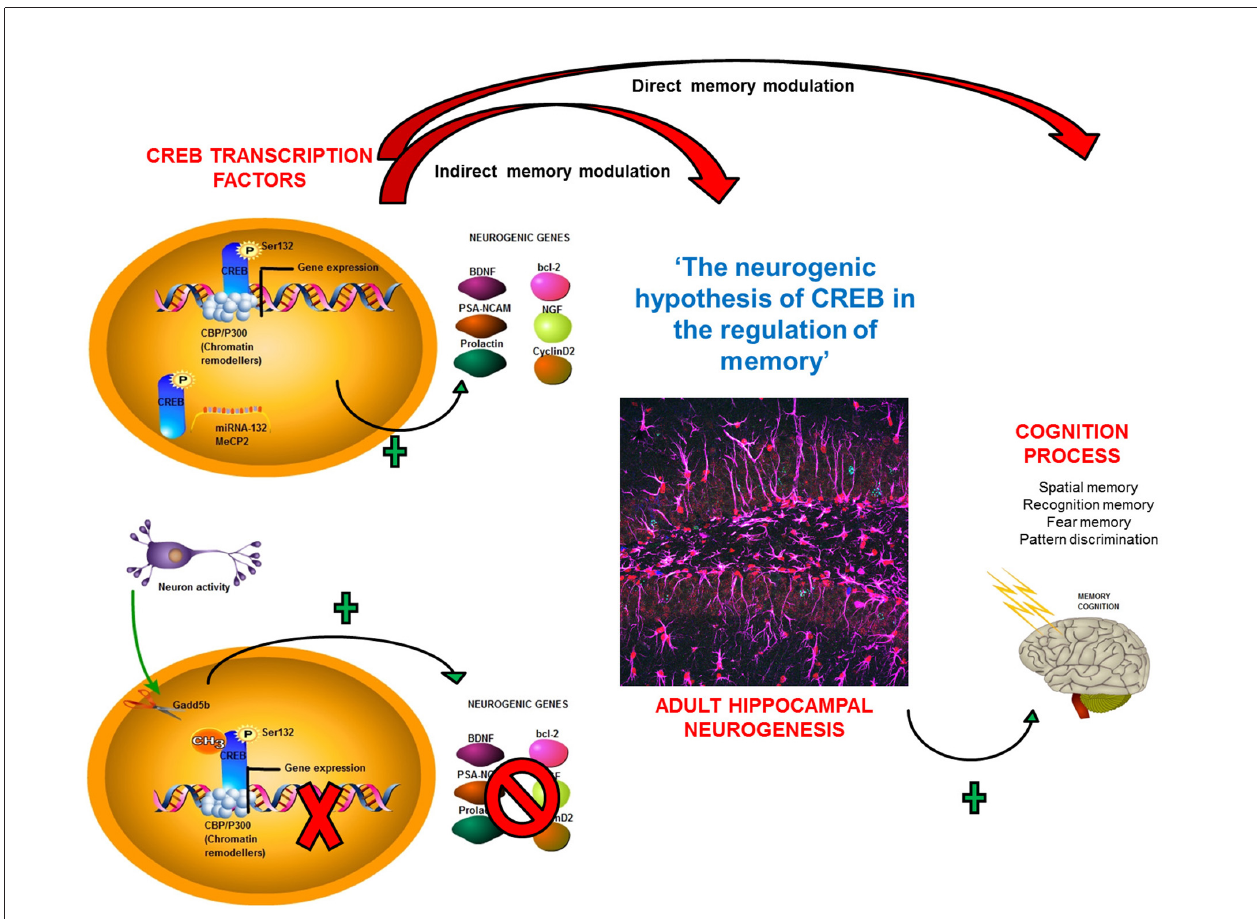
FIGURE 3 | Neurogenic hypothesis for CREB’s role in the regulation of memory. A summary of how CREB can influence this cognitive process of memory formation through its direct participation in, or through its modulation of, adult hippocampal neurogenesis (AHN), constituting a new theory for CREB regulation of